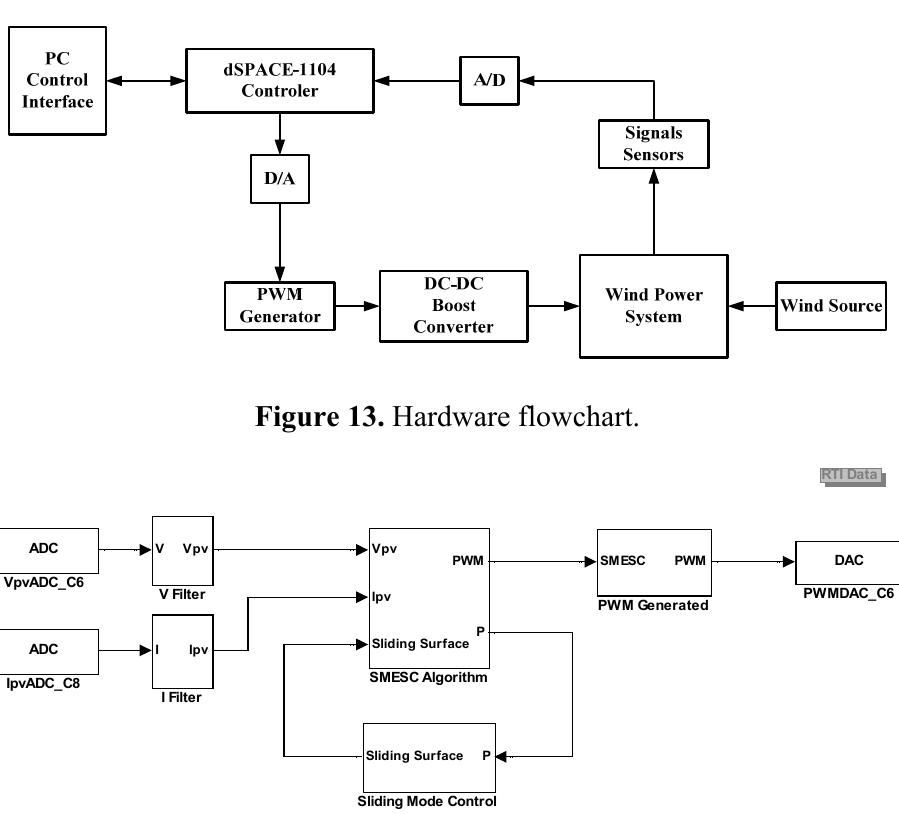
Figure 14. Test program block diagram. Sliding Mode Extremum Seeking Control